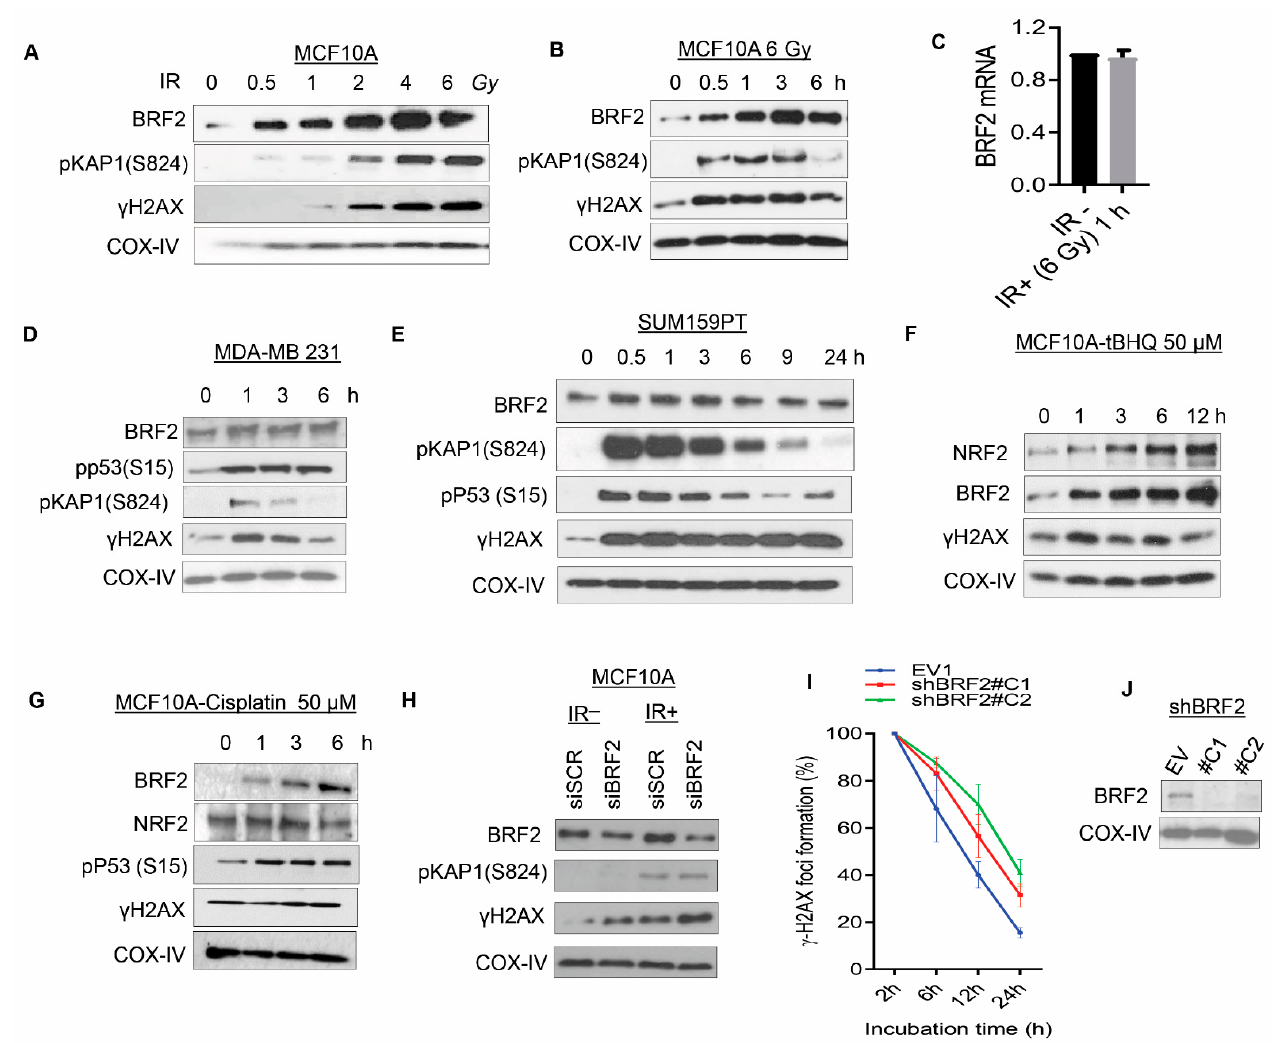
Figure 2. BRF2 is a potential DNA damage regulatory gene. ( A ) The dose-response of BRF2 and other DNA damage response (DDR)-related proteins in MCF10A after exposure to the indicated dose of ionizing radiation (IR). ( B ) Time course of BRF2 expression following 6 Gy IR in MCF10A. ( C ) BRF2 mRNA expression in MCF10A post-1 h exposure to IR (6 Gy).